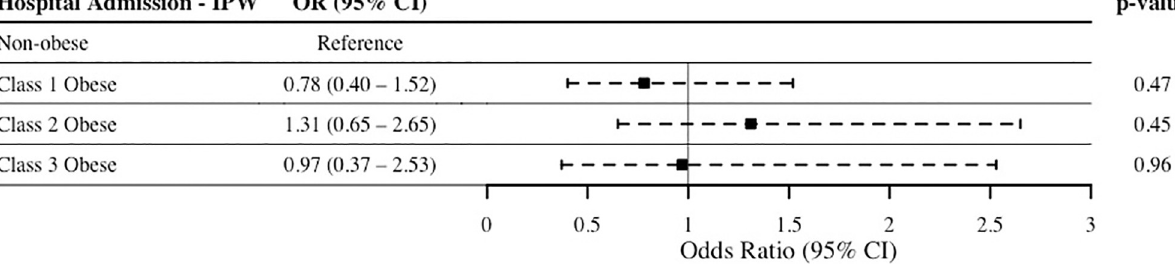
PLOS ONE | https://doi.org/10.1371/journal.pone.0272331 August 11,